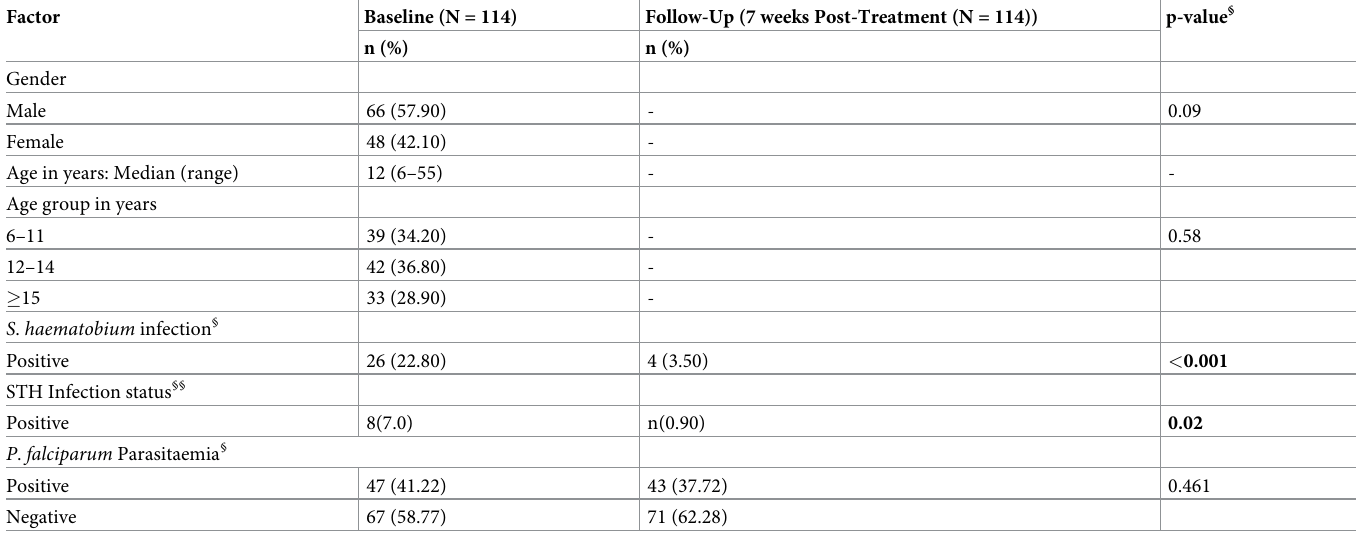
Table 1. Characteristics of Study Cohort.